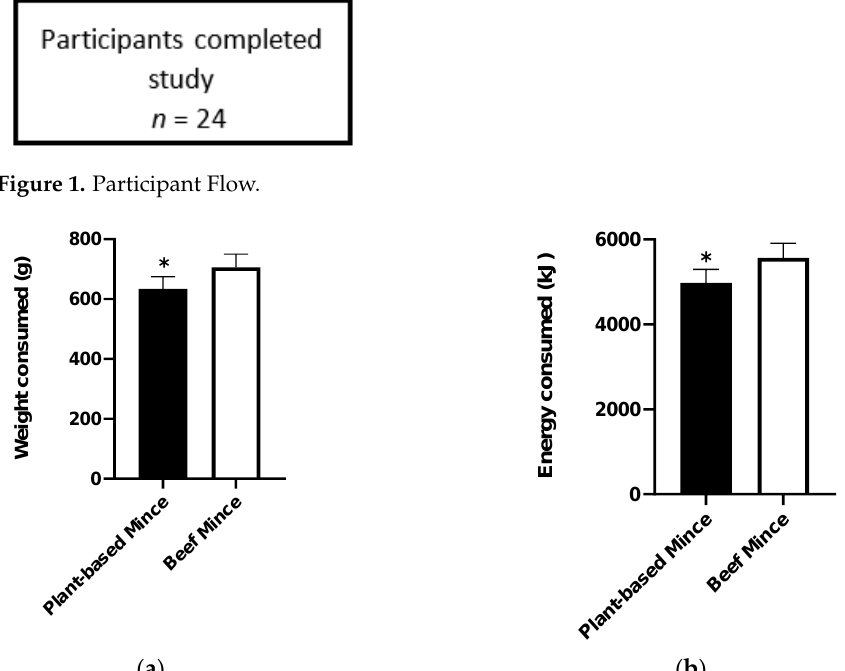
Figure 2. ( a ) Weight and ( b ) Energy consumption of the pasta lunch meal prepared with plant-based (filled histograms) and beef (open histogram) mince. Both weight and energy intake of the pasta lunch meal was lower for the meals prepared with plant-based mince compared to beef mince (*, paired t -test, p < 0.05).